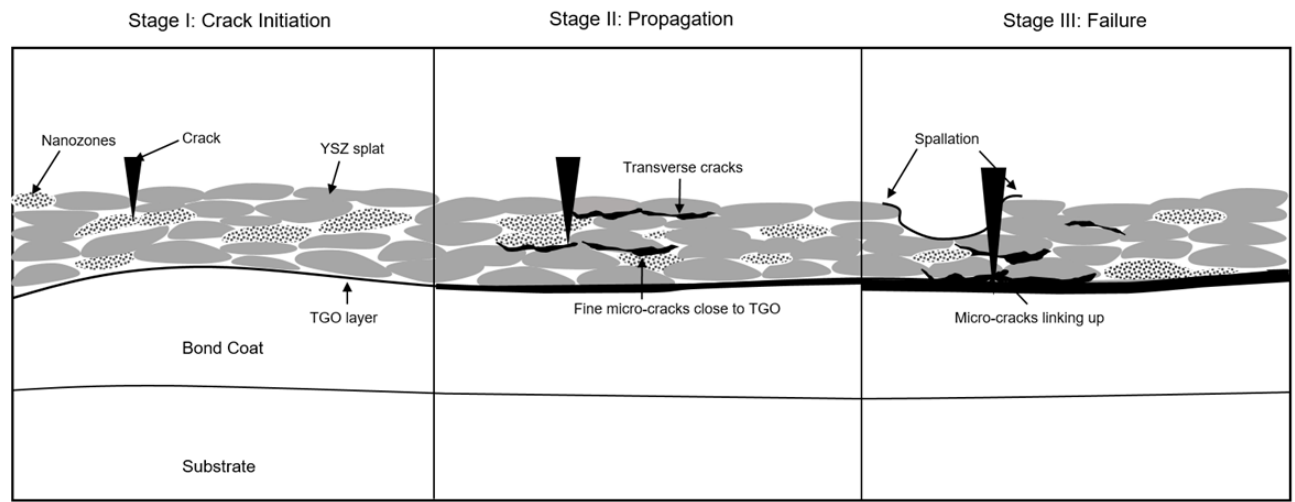
Figure 8. Schematic illustration of the three stages of damage progression in TC microstructures leading to the failure of N tbc .